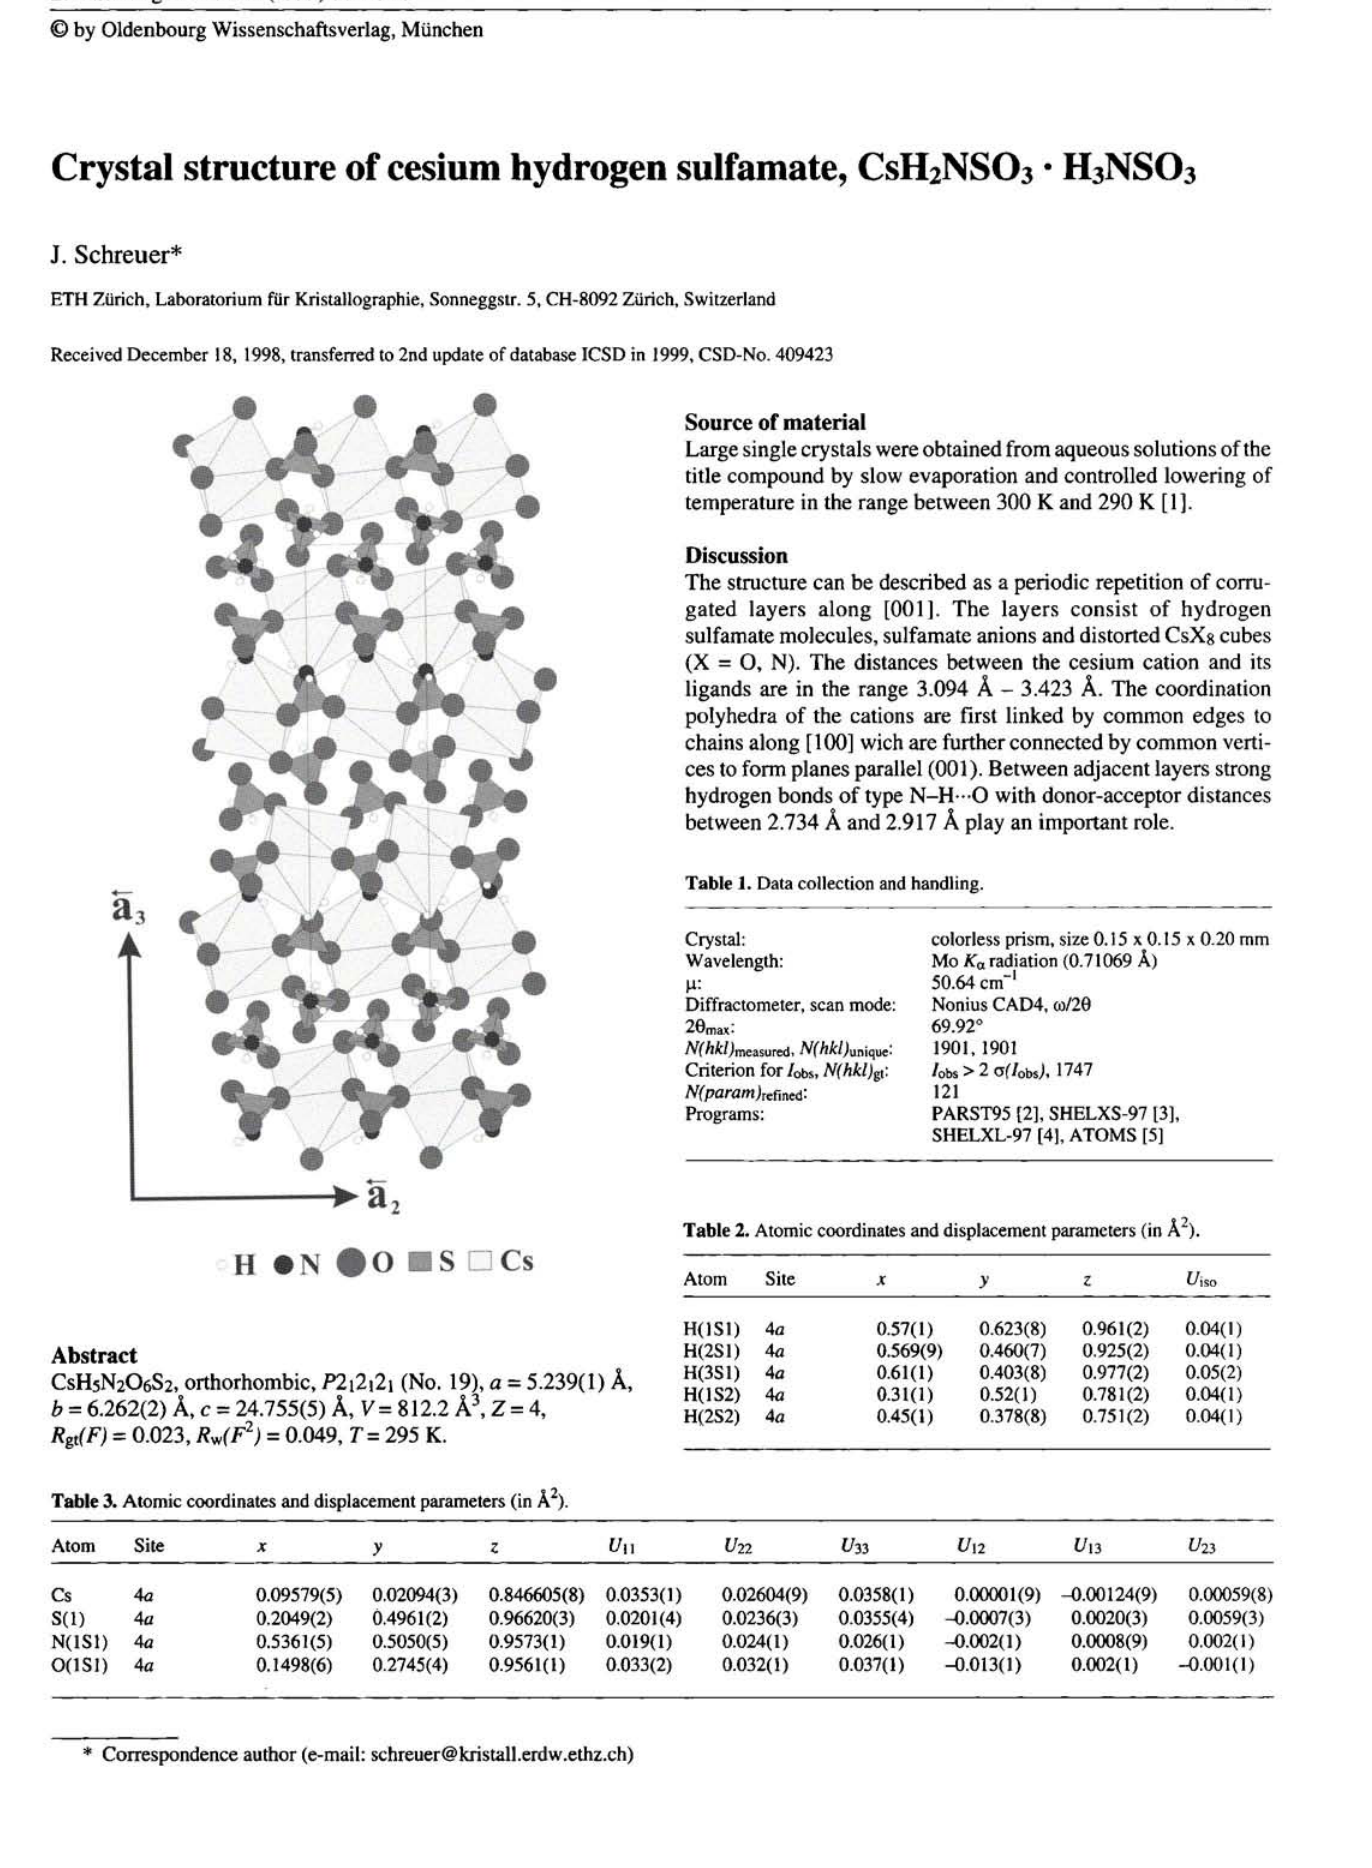
Table 2. Atomic coordinates and displacement parameters (in Â 2